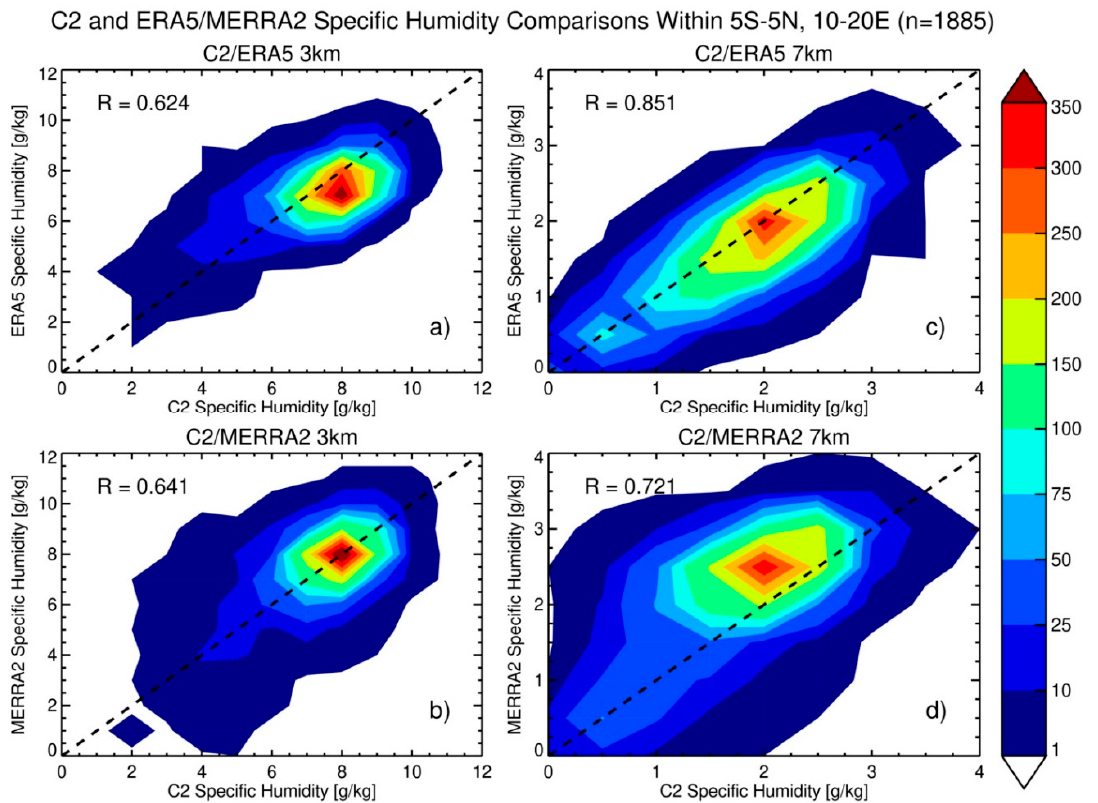
Figure 10. ( a , c ) Sampling distribution of C2 and ERA5 specific humidity at 3 km and 7 km, and ( b , d ) sampling distribution of C2 and MERRA-2 specific humidity at 3 km and 7 km within 5° S–5° N, 10° E–20° E from September–December 2019. The number of collocated profile pairs is shown in the title and the correlation coefficient is also shown on each panel.